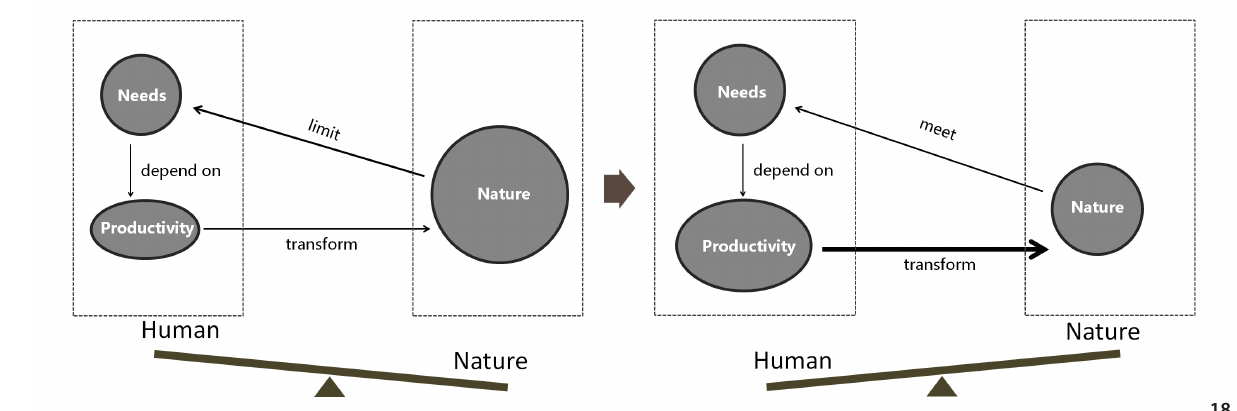
Figure 18 The change in the relationship between human and nature (Source: the